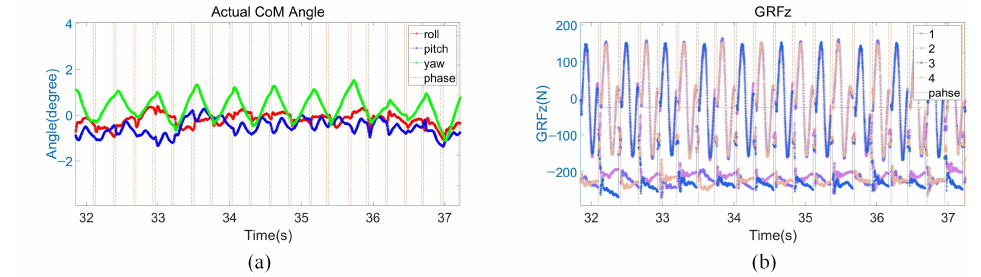
Figure 10. Grassland and rockland experiment data. ( a ) Robot body angle. The red, blue, and green lines present the robot body roll, pitch and yaw angles; ( b ) GRF in the z-direction.